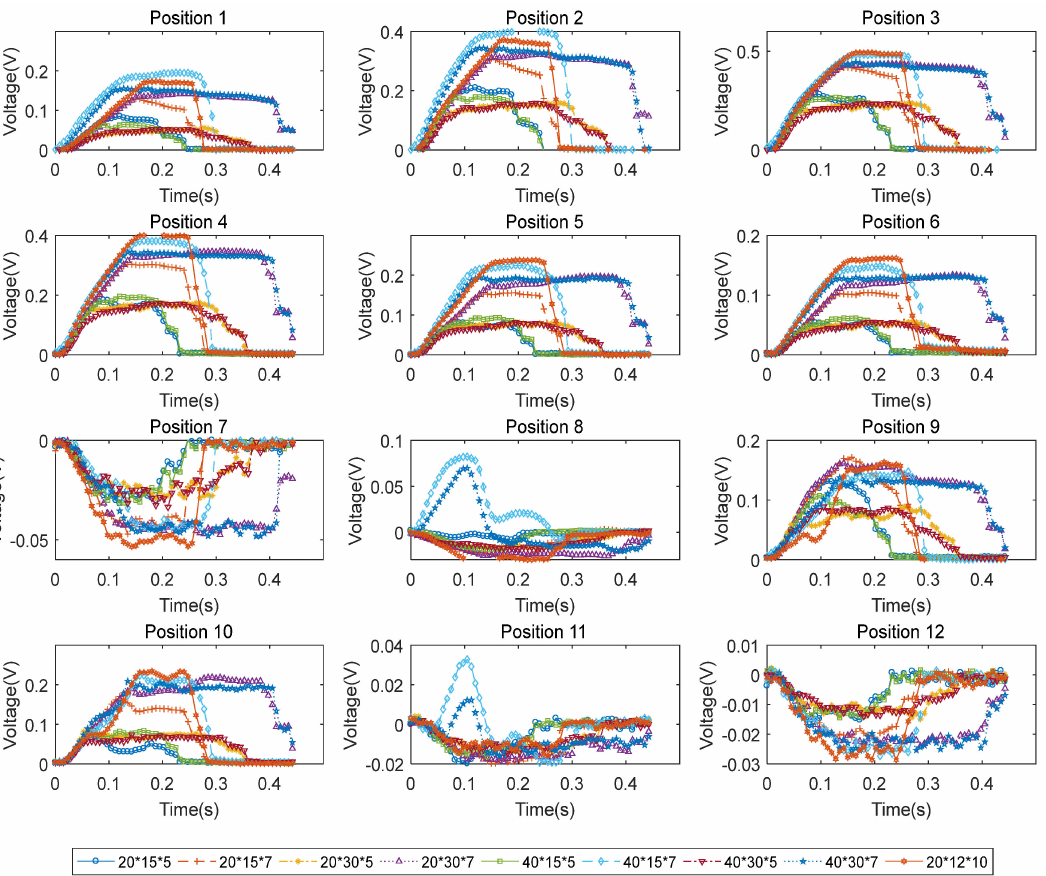
Figure 10. Output voltage signals of No. 1–12 strain gauges when crossing over different mock debris blocks. Note: the bottom legends denote the size of the block, in length by width by height in